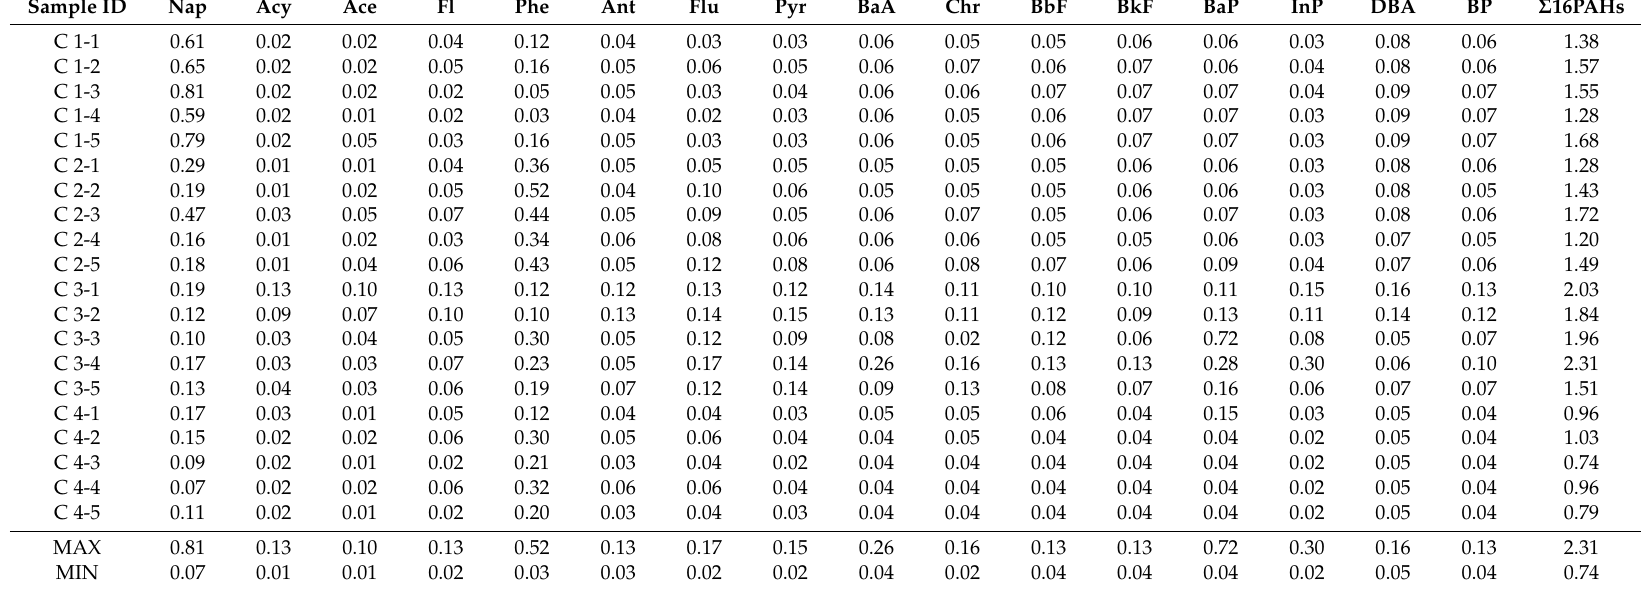
Table 5. Assessment of daily exposure via dust ingestion for construction